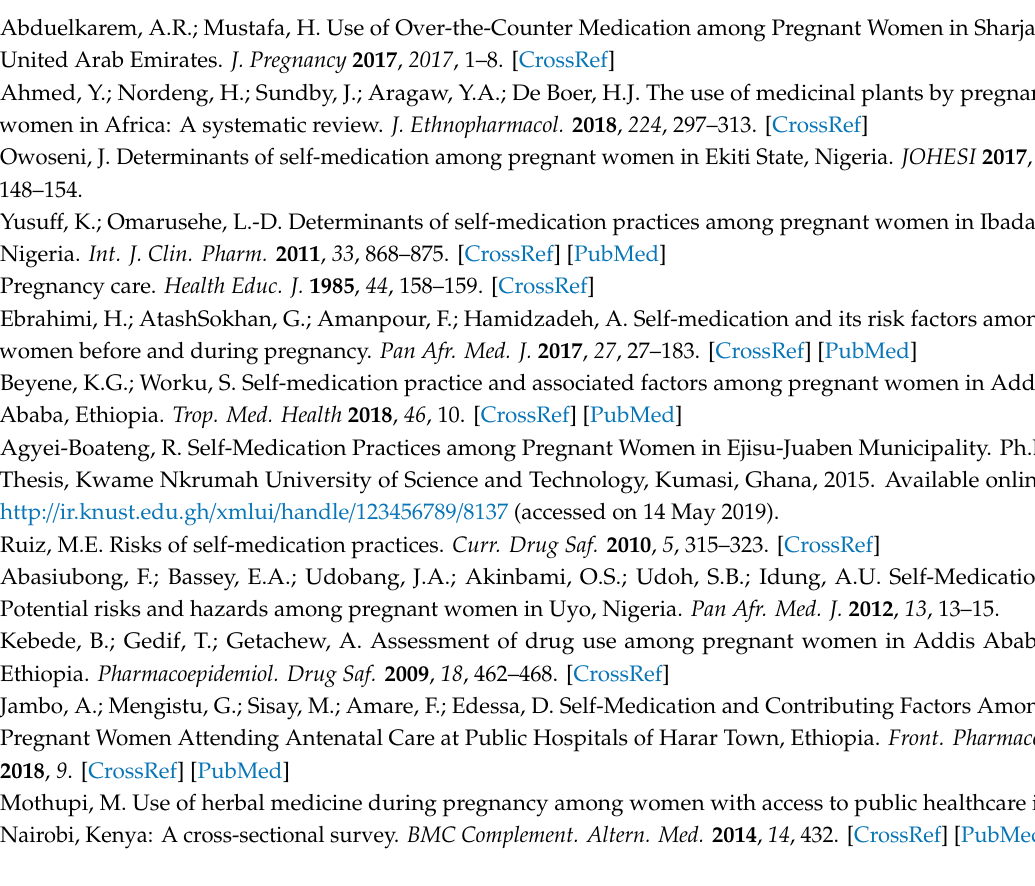
Table S1: Medicinal plants used along with self-medication among pregnant women prior to admission to JUMC, Ethiopia; Table S2: Characteristics of pregnant women according to social drug use prior to admission to JUMC,